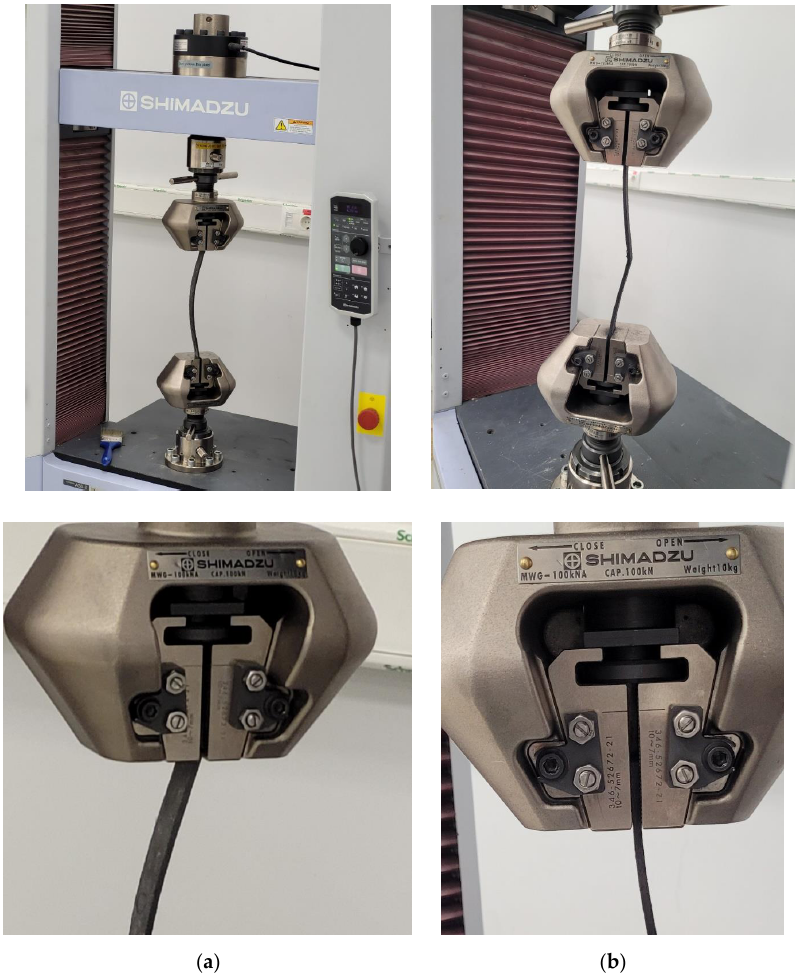
Figure 5. Test setups depending on boundary conditions. ( a ) simple – simple; ( b ) clamped – clamped.